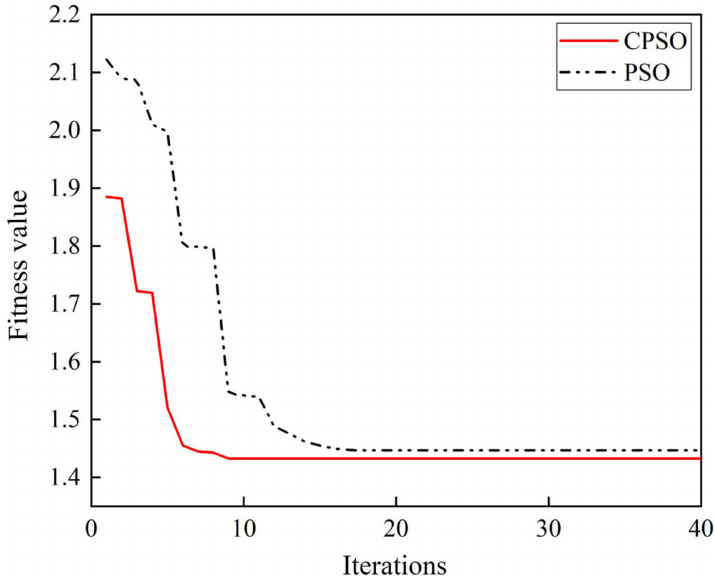
Figure 3. Convergence process of CPSO and